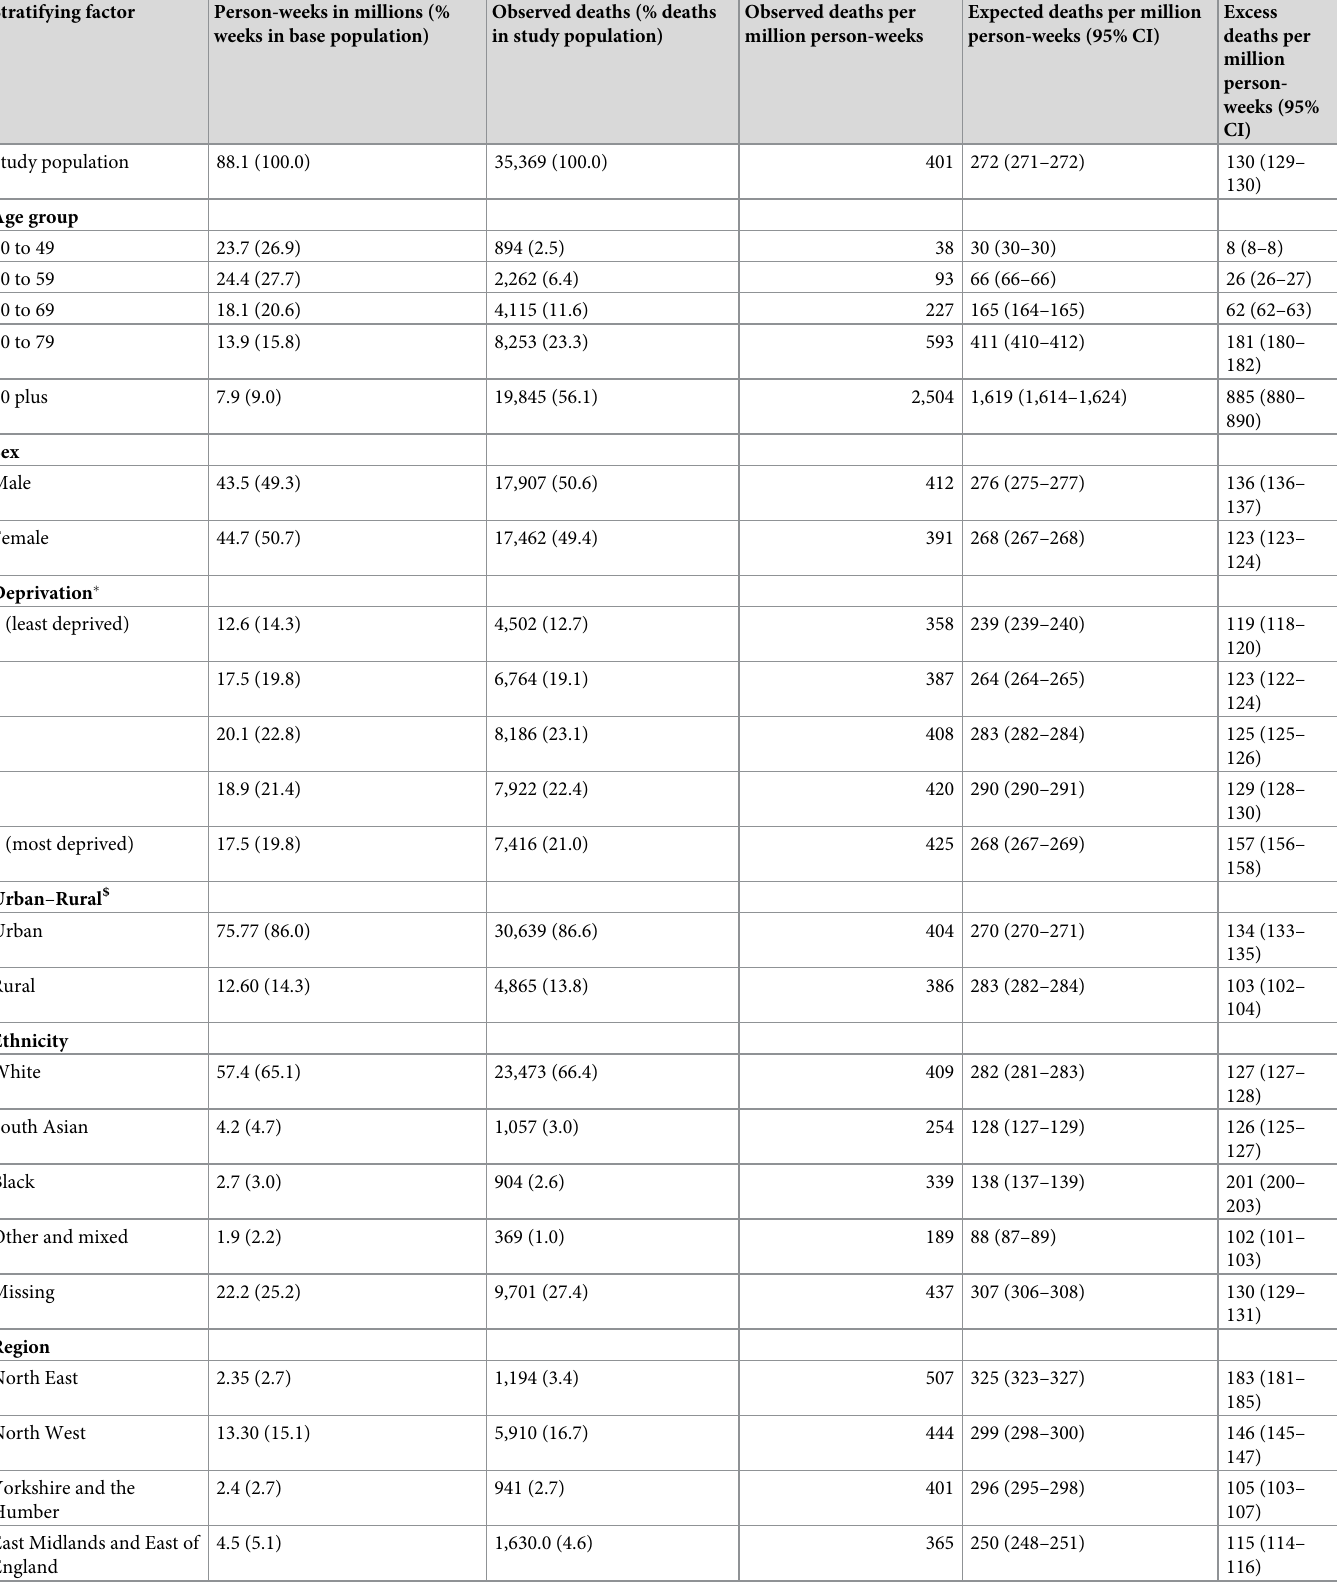
Table 1. Number of person-weeks and observed, expected, and excess number of deaths during Wave 1 (5 March to 27 May